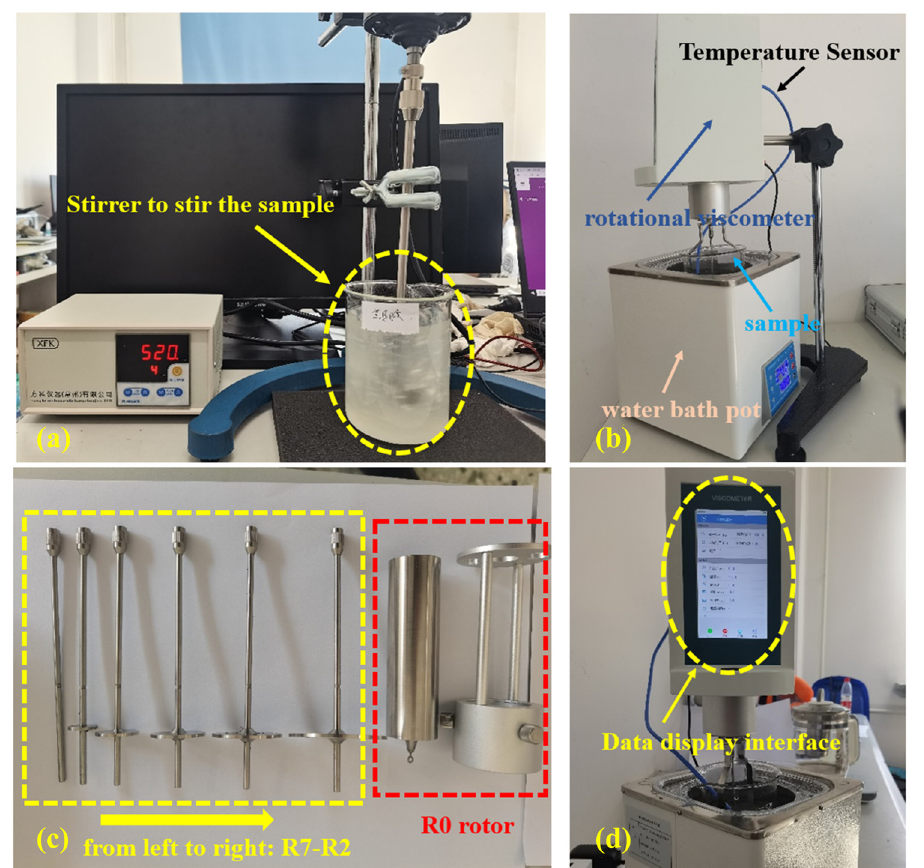
Figure 3: Thickening liquid sample stirring and measurement experiment: ( a ) thickening liquid stirring process, ( b ) measurement experi - ment, ( c ) rotor model of rotational viscometer, ( d ) data and time display.